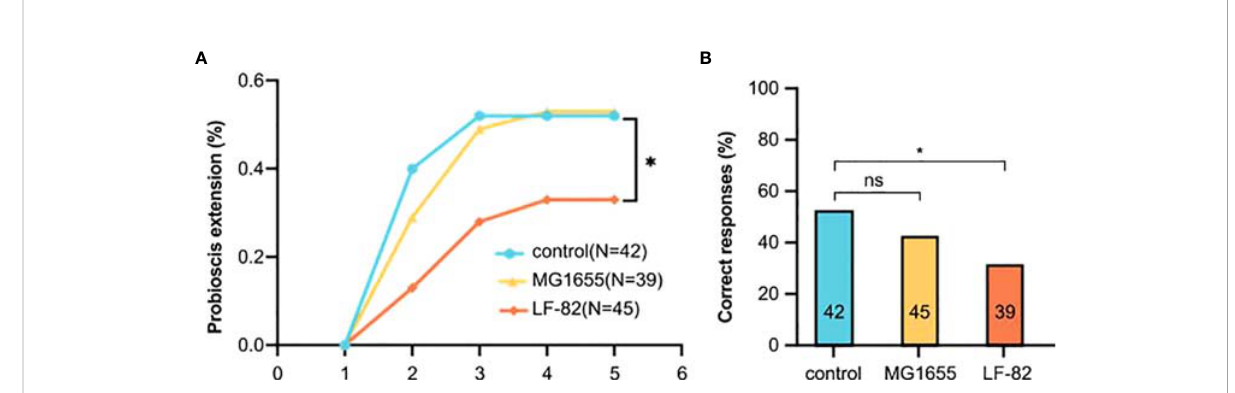
FIGURE 5 LF82 impairs learning ability of the honeybee. (A) Learning curves to a positively rewarded conditioned stimulus (CS). Honeybees in the LF82 group showed impaired ability of learning (* p < 0.05). (B) Performance in the memory test is shown as percentage of responses to the CS only; numbers in bars are sample sizes. (* p < 0.05; ns, not statistically signi fi